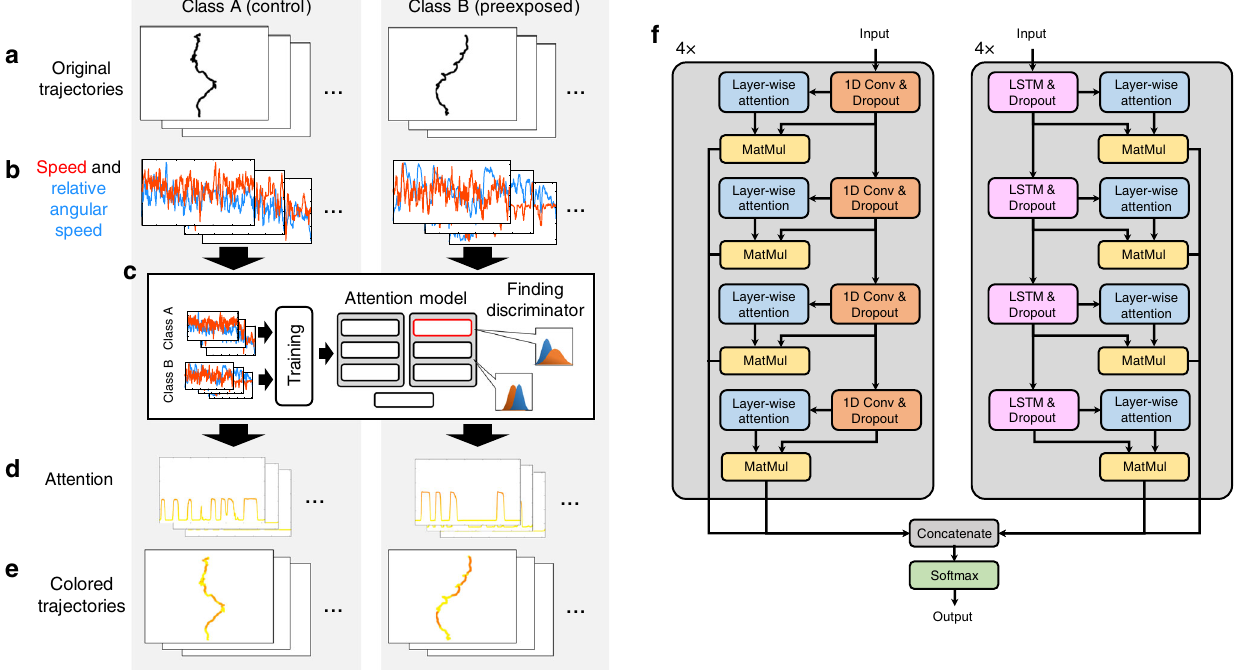
Fig. 2 DeepHL trajectory highlighting. We assume that the trajectories of two classes are given: class A and class B in this example, which corresponds to worms without and with prior odor learning, respectively. a , b Trajectories, that is, a time series of two-dimensional coordinates, are converted into time series of speed and relative angular speed to achieve position- and rotation-invariant analysis. c DeepHL-Net is trained on the time series and then a discriminator layer is found using its attention values. d The discriminator layer outputs a time series of attention values when a trajectory is fed into the trained DeepHL-Net. The length of the time series is identical to that of the time series of speed and relative angular speed. e Each trajectory is colored with its corresponding attention values obtained by the layer. In our system, a large attention value is encoded as red and a small attention value is encoded as yellow, as shown in Fig. 1b. f Proposed multi-scale layer-wise attention model (DeepHL-Net). The input and output of this model are the time-series primitive features and predicted class, respectively. The model consists of four stacks for the convolutional layers and four stacks for the LSTM layers to extract features at different levels of scale. Blocks labeled “ 1D Conv and Dropout ” and “ LSTM and Dropout ” indicate the 1D convolutional layer and long short-term memory (LSTM) layer with dropout, respectively. The “ Layer-wise attention ” block calculates the attention of the outputs of a convolutional/ LSTM layer using Eq. (1). The “ MatMul ” block multiplies the attention and the outputs of the layer to re fl ect the segments paid a high level of attention in the classi fi cation result. The “ Softmax ” block indicates the output softmax layer. For more details about the model, see “ Methods ”